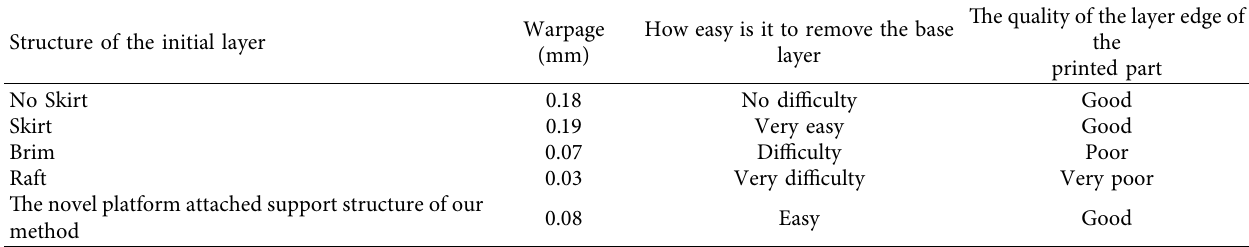
Figure 12: Printed actual object of test model. (a) The edge structure of the Skirt. (b) The edge structure of the Brim. (c) The edge structure of the Raft. (d) The edge structure of the novel platform attached support structure. Table 1: Comparison of different Skirt